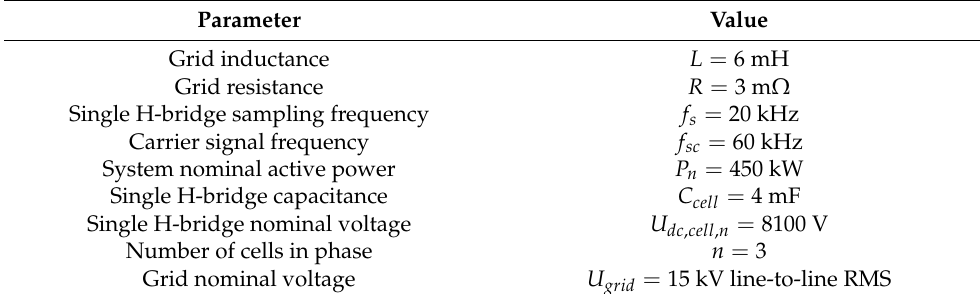
Figure 8. Simulation model. Table 1. Simulation model parameters.